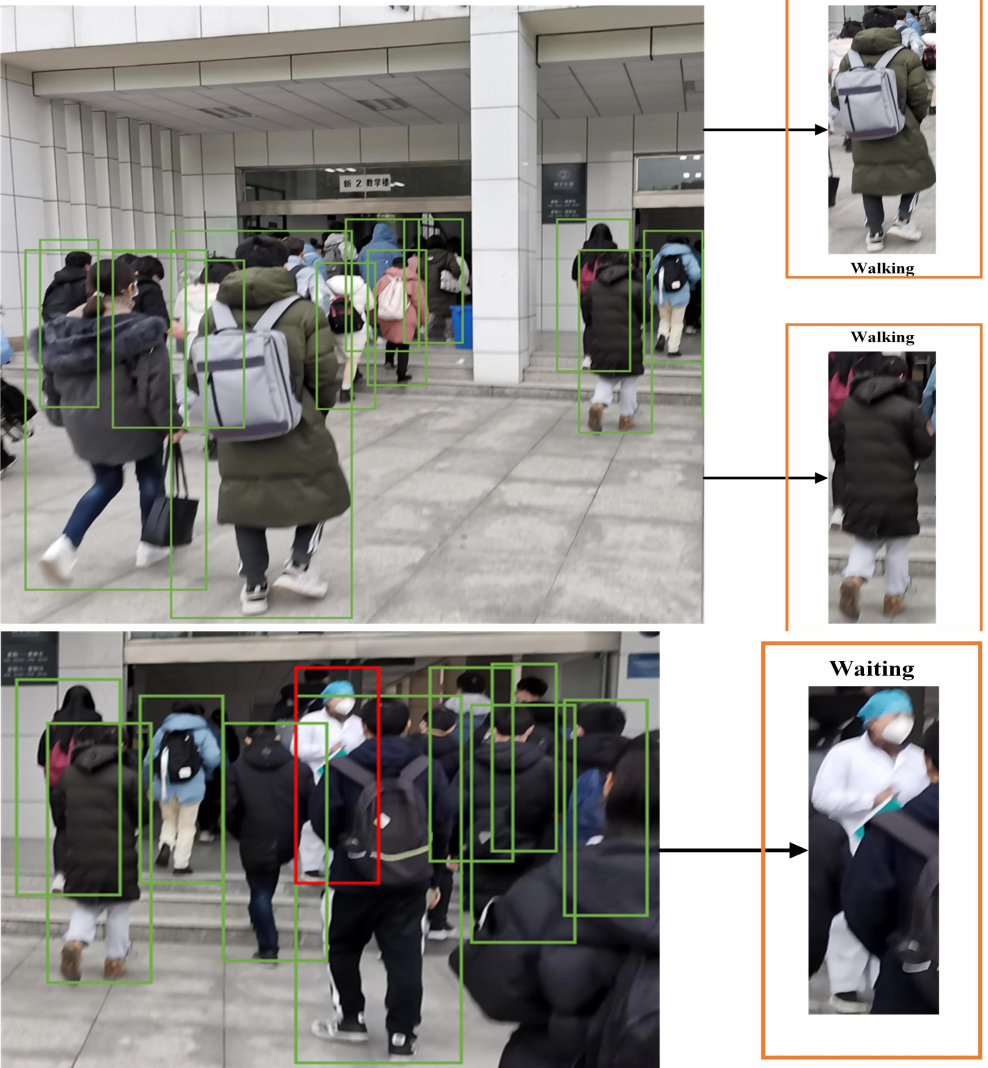
Figure 6. Qualitative results of the collective activity dataset. The color of the bounding box represents the action label (green: walking, red: